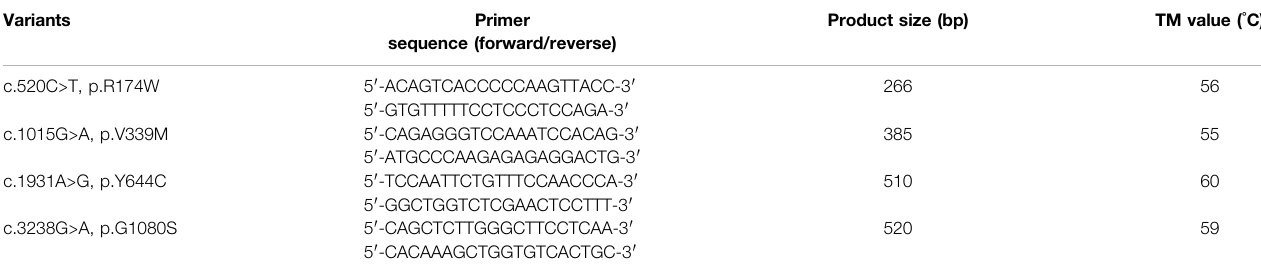
TABLE 1 | Primers used in polymerase chain reaction (PCR) for the ampli fi cation of the CPAMD8 gene.